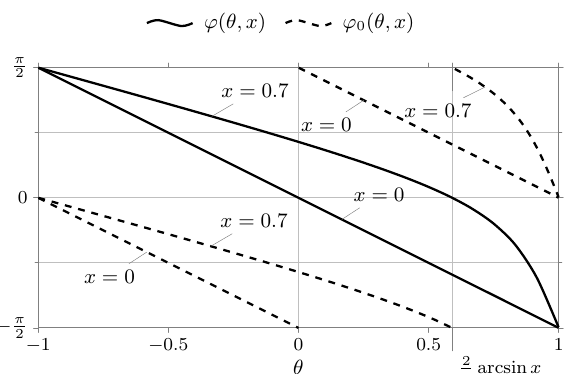
Figure 6. The graph of the function ϕ ( θ , x ) and ϕ 0 ( θ , x ) depending on the parameter θ in the case x < 1 (The graphs are plotted for x = 0.7 and x =